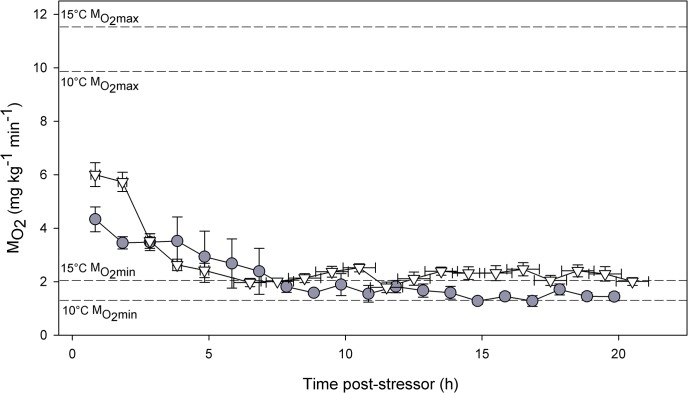
Mean ± S.E. oxygen consumption rate (Ṁ
O2) for fish recovered in static respirometers after the capture simulation at 10°C (grey circles) and 15°C (white triangles).The total sample size was five individuals at 15°C (two following 2 min of entanglement, three following 15 min) and four at 10°C (all 15 min entanglement time) but the sample size was smaller for some time points where individuals exhibited spontaneous activity, reflected by sudden increases in Ṁ
O2 (and confirmed by visual observation of respirometry chambers). Temperature-specific maximum (Ṁ
O2max) and minimum (Ṁ
O2min) aerobic metabolic rates for this population of coho salmon were measured in a separate experiment and are shown using dashed lines for illustrative purposes—maxima were obtained using a Brett-type swim tunnel respirometer (G.D. Raby, unpublished data).